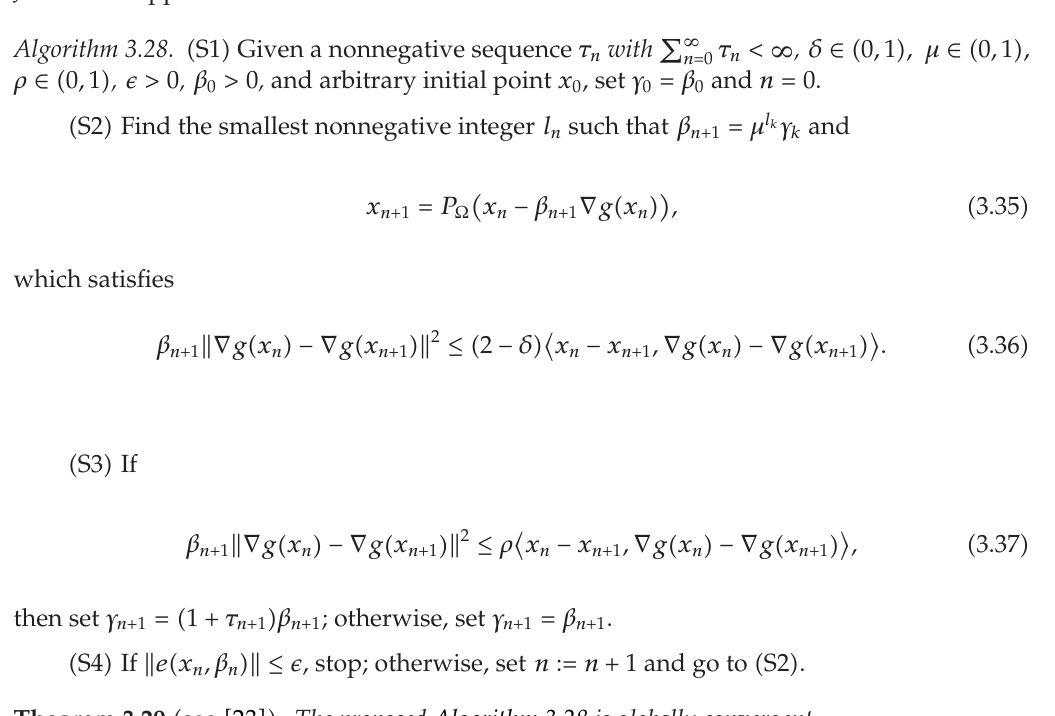
Algorithm 3.28. (cid:2) S1 (cid:3) Given a nonnegative sequence τ n with